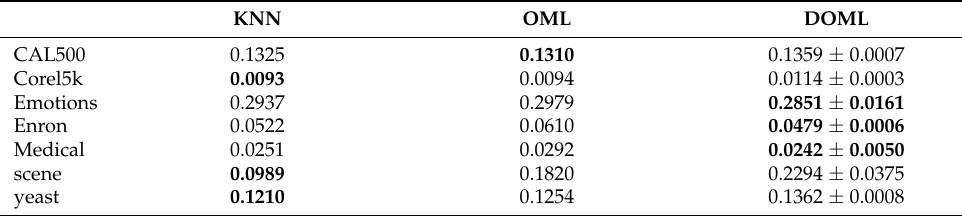
Table 3. Hamming loss of different algorithms with full benchmark